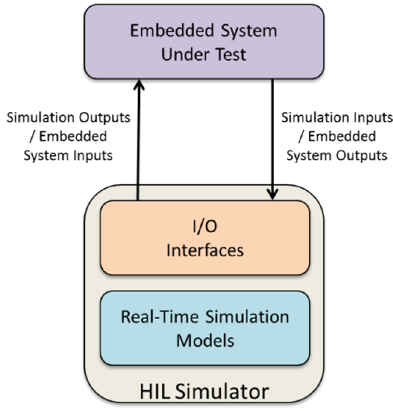
Figure 7. Overview of Hardware-In-The-Loop (HIL) testing of embedded real-time systems.